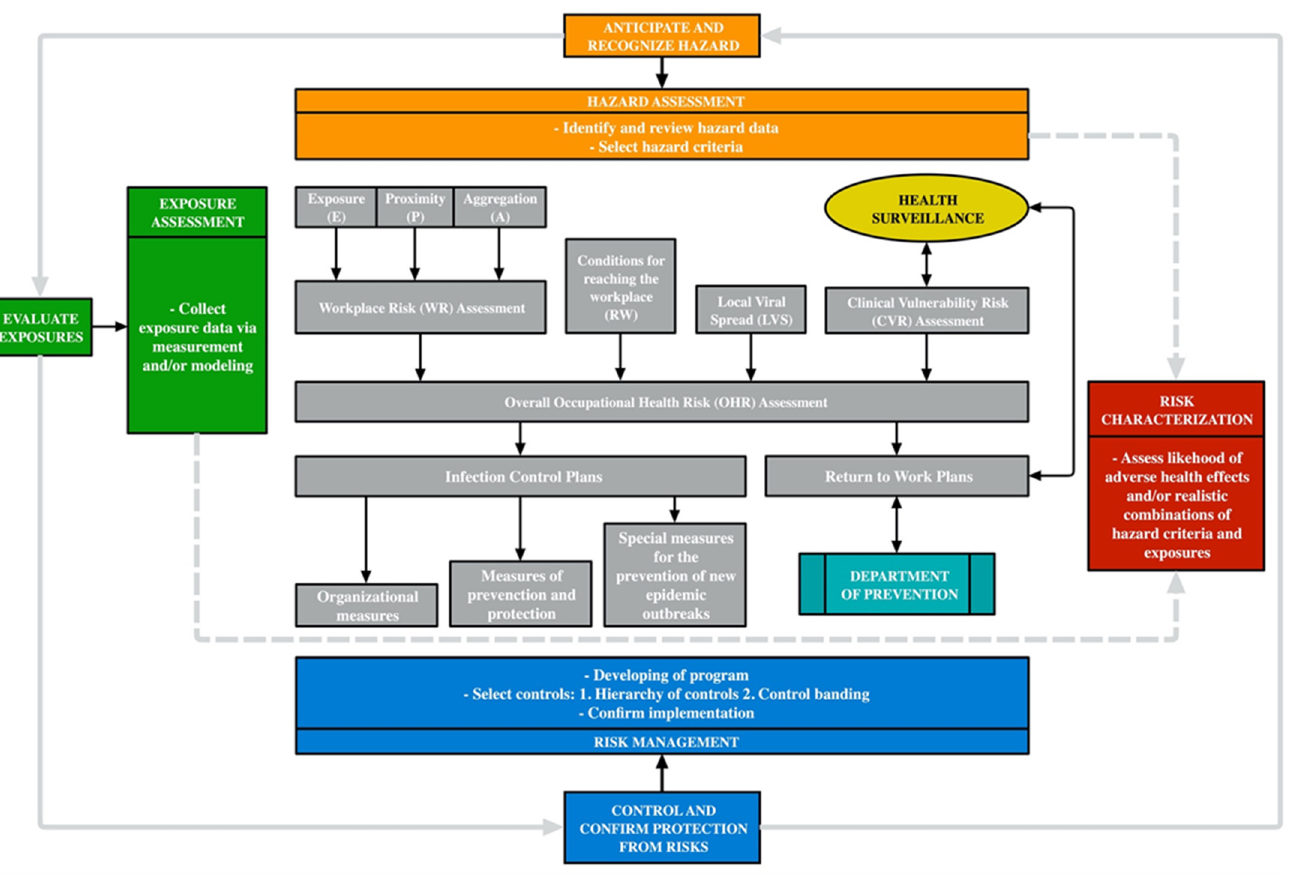
Figure 2. Summary of the proposed risk assessment and management workflow.